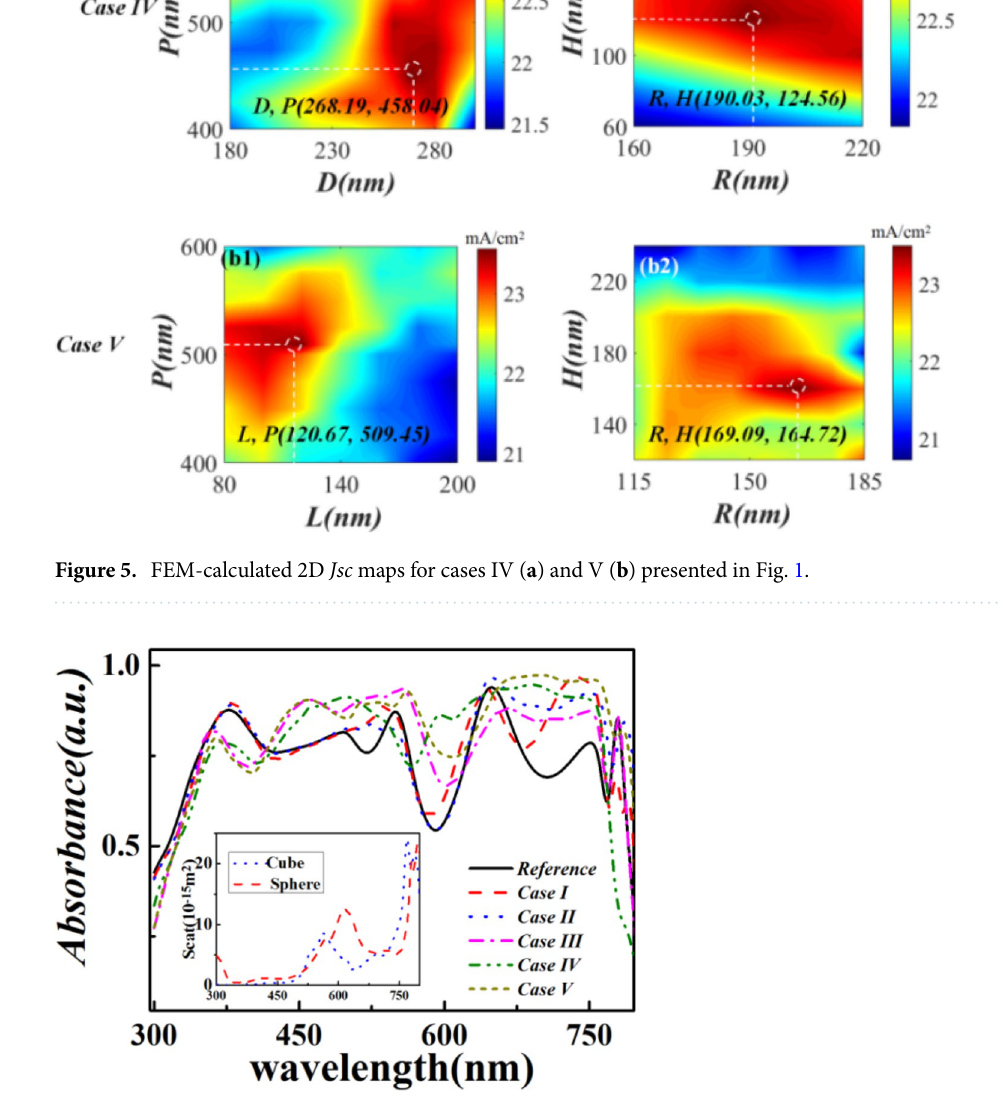
Figure 6. Comparative plots of the optimized absorption spectra of the five proposed cases of solar cells presented in Fig. 1 along with the spectrum of the